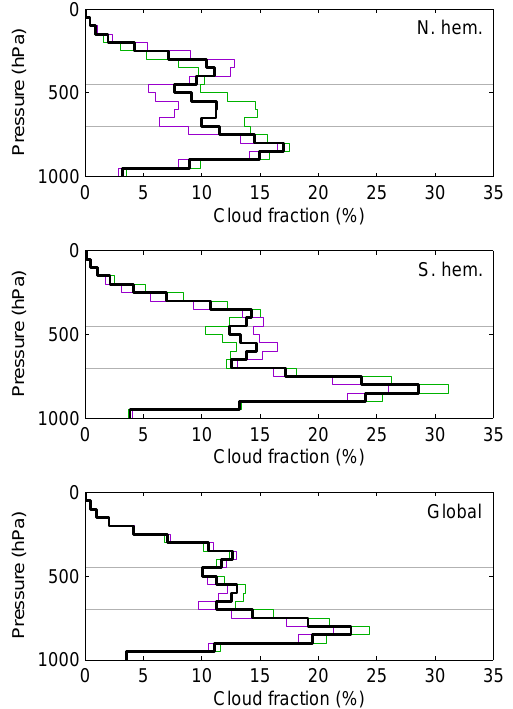
Fig. 3. Average cloud fraction with altitude following Rossow et al. (2005, and W. Rossow, personal communication, 2009). (a) North- ern Hemisphere. (b) Southern Hemisphere and (c) global for Jan- uary (green), July (purple) and mean (black). Grey horizontal lines separate high, mid- and low-level clouds.